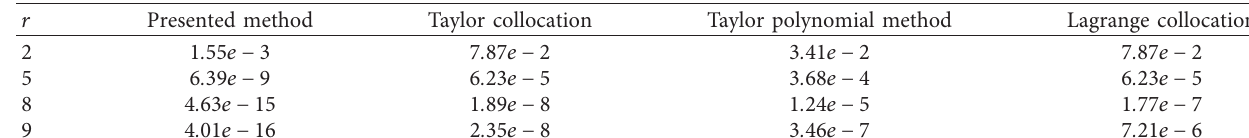
Figure 3: Effects of the refinement level J and multiplicity parameter r for Example 2. Table 2: Comparison of the error for Example 1.